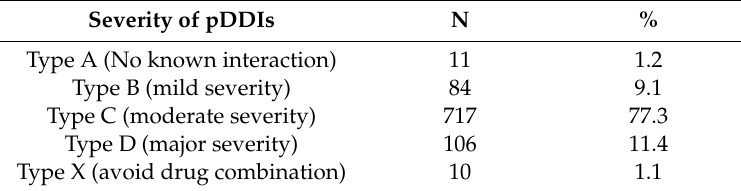
Table 3. Severity of potential drug–drug interactions (pDDIs; n = 928) among studied chronic kidney disease (CKD) patients.